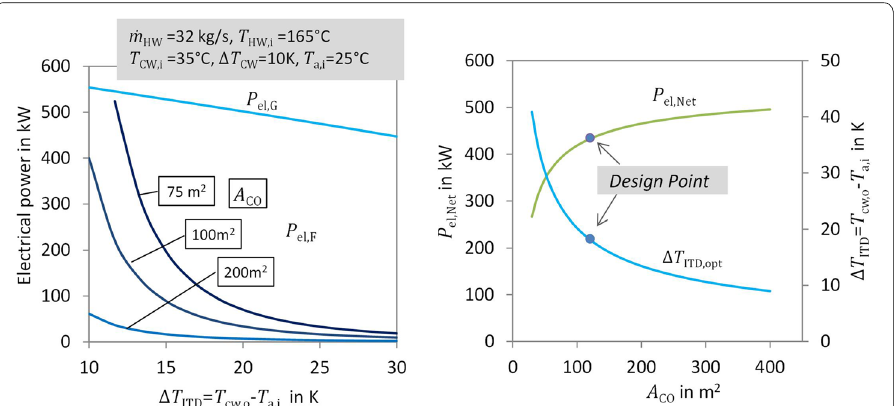
Fig. 5 Generator power and fan power depending on the initial temperature difference (left) and net power and optimal initial temperature difference depending on the dry cooler cross-section